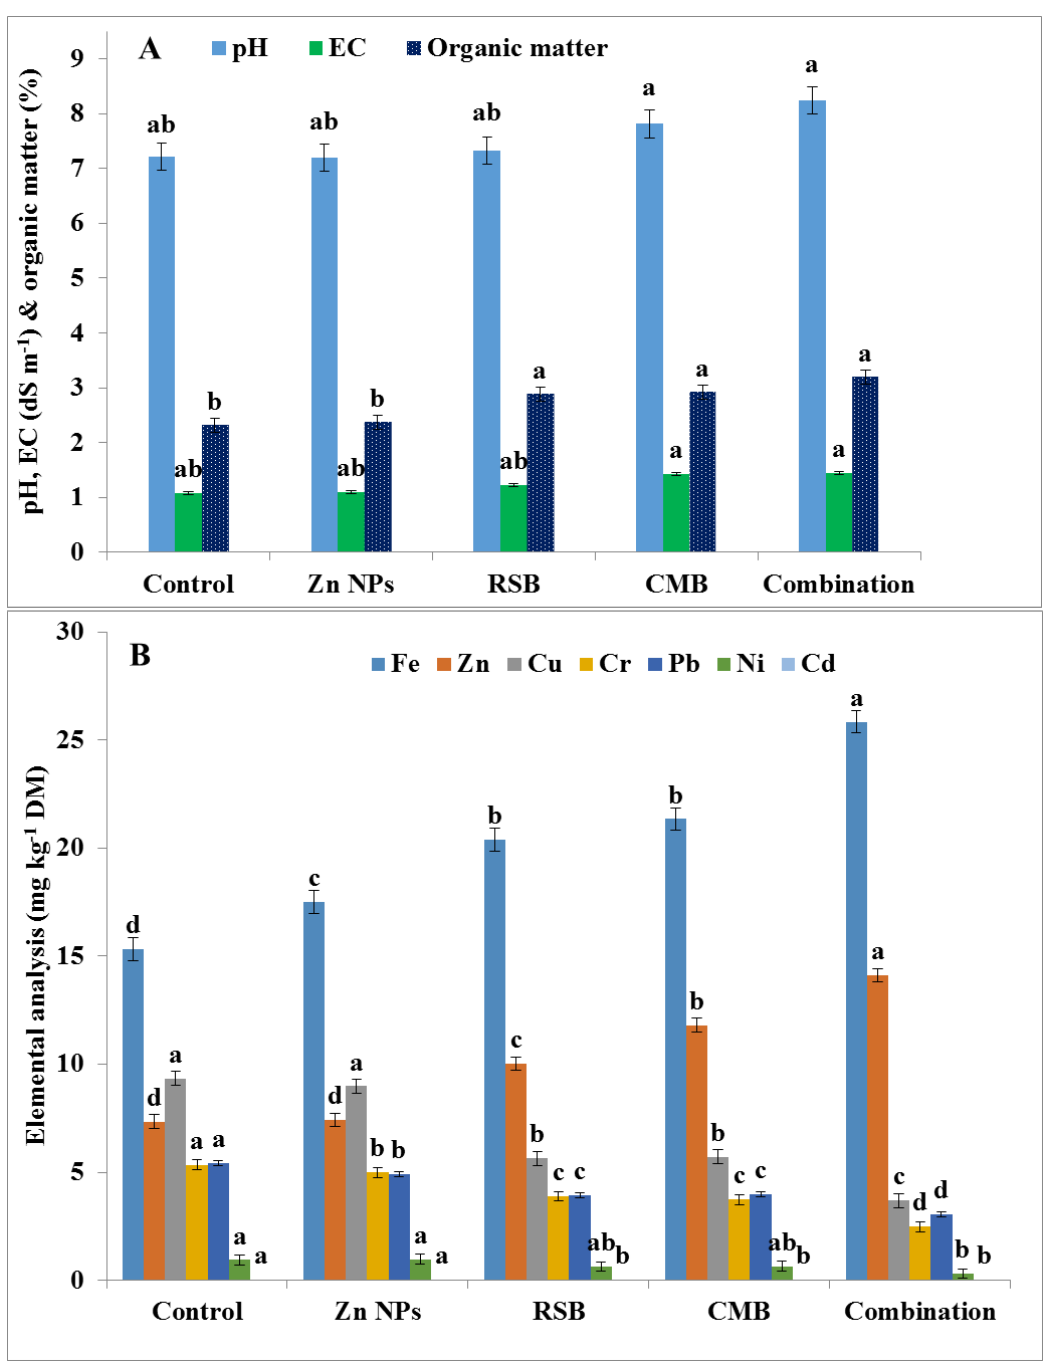
Figure 1. Effect of zinc nanoparticles and biochar of rice-straw and cow-manure on soil pH, EC, organic matter ( A ), and available heavy metals ( B ) after harvesting sunflowers grown in soil irrigated with wastewater for long-term (Data are the combined statistical analysis over the two seasons). Zn NPs = Zinc nano-particles, RSB = Rice straw biochar, CMB = Cow manure biochar, DM = dry matter, Error bars = Standard error of means (SEM). Means with different superscripts a−e for the same color of columns are significantly different at probability ( p ) ≤ 0.05.